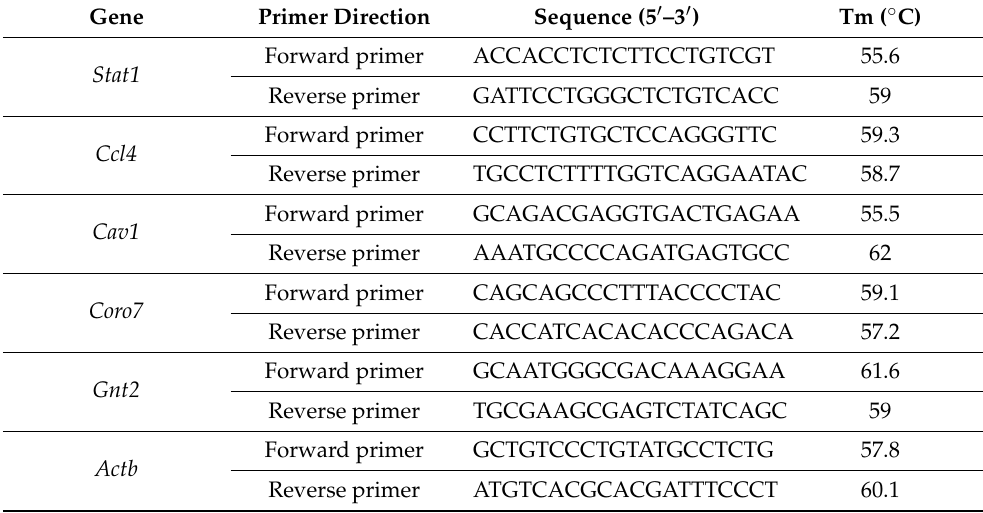
Table 1. Real time PCR primer pairs of selected